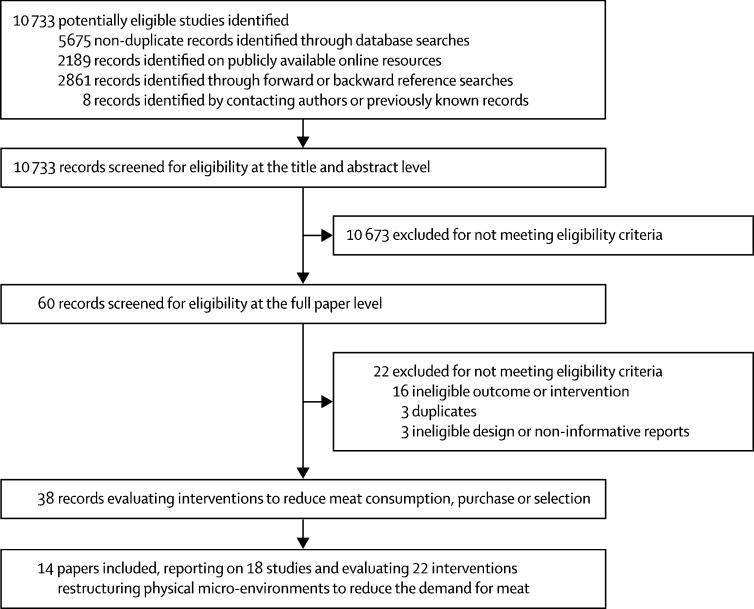
Study selection